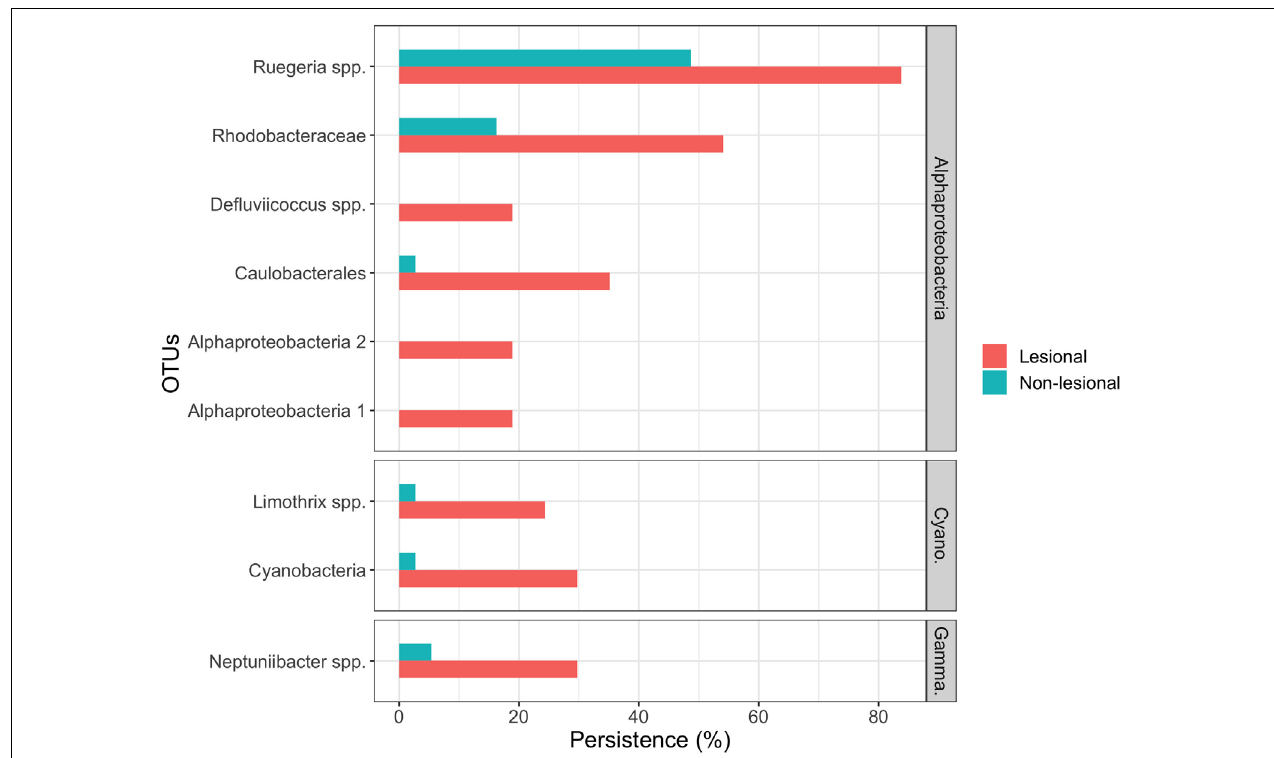
FIGURE 6 | A summary of OTUs that are significant indicators for lesional corals. OTUs are grouped by Alphaproteobacteria, Cyanobacteria (Cyano.), and Gammaproteobacteria (Gamma.). OTUs were required to be in at least seven samples as well as have a Sidak corrected p -value of greater than 0.05 in the species indicator